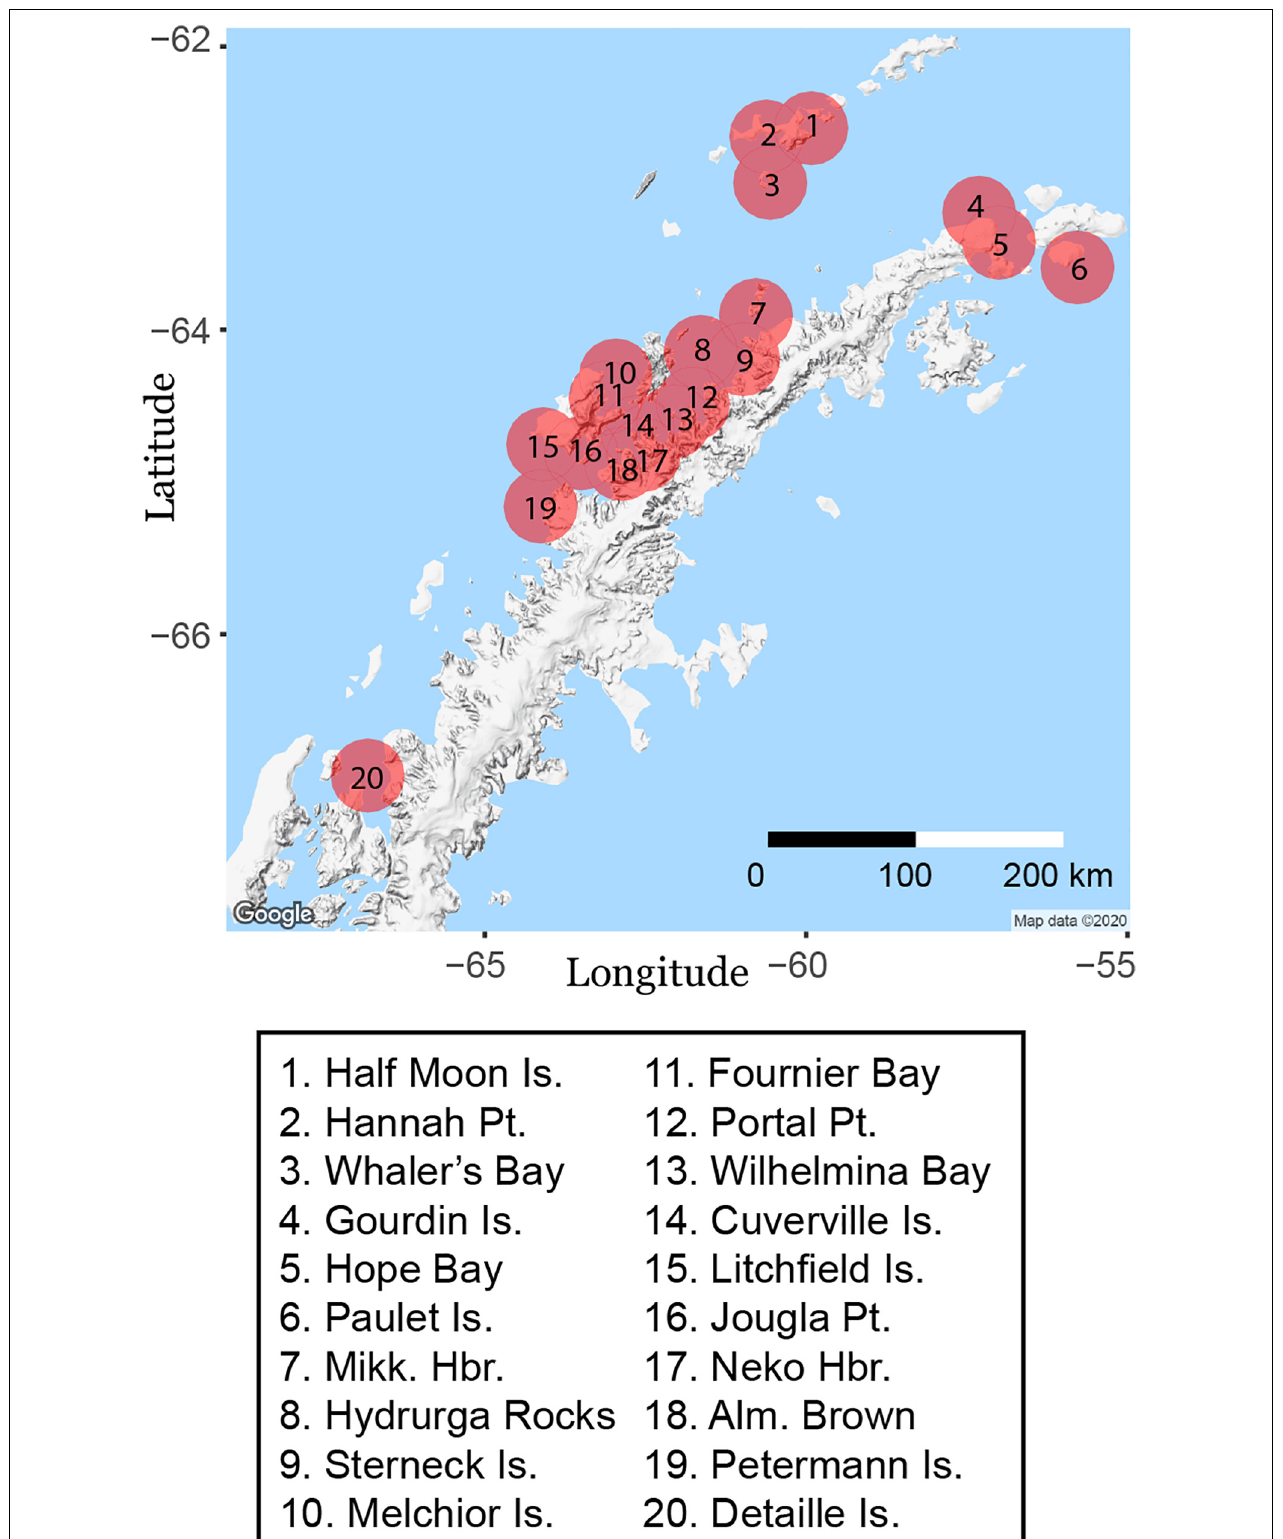
FIGURE 1 | Locations and extent of web-crawler geographic queries on the Antarctic